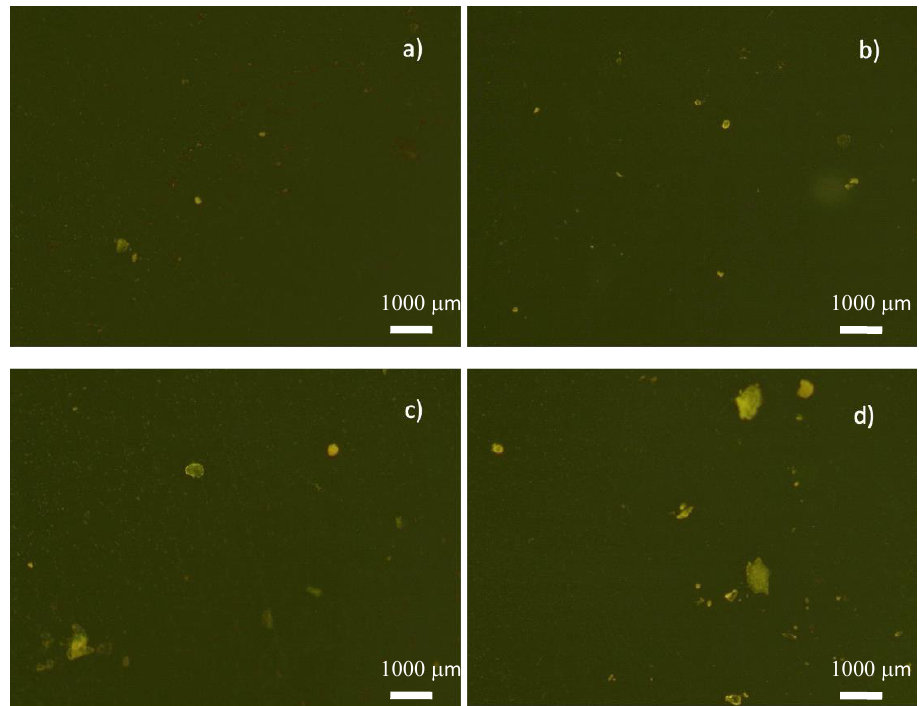
Figure 1. Fluorescence microscopy of asphalt binder with Jatropha curcas shell particles:( a ) J2, ( b ) J4, ( c ) J6, and ( d ) J8.